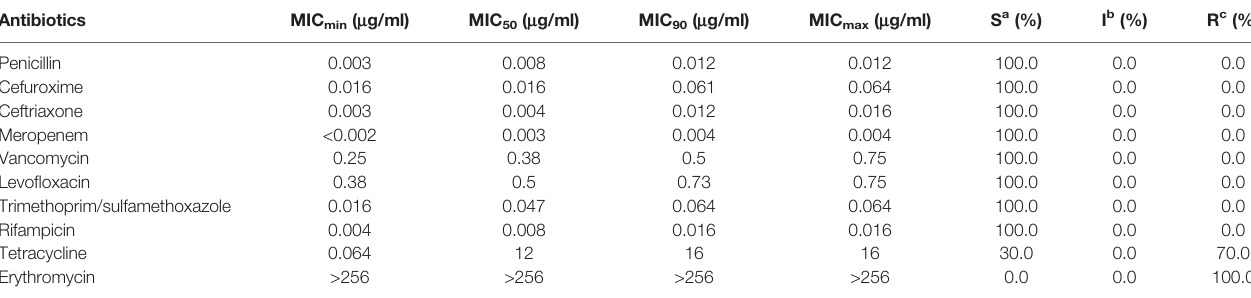
TABLE 2 | Antimicrobial susceptibility of 20 Streptococcus pneumoniae isolates. Antibiotics